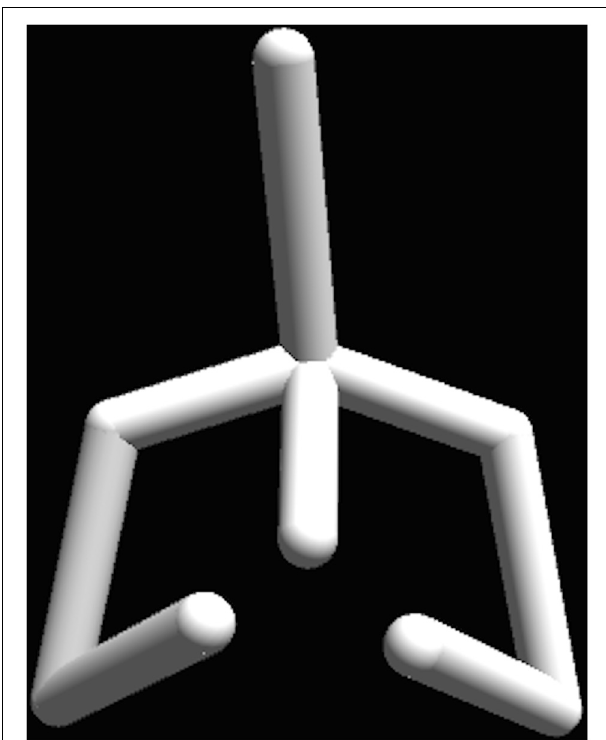
FIGURE 1 | The stick-figure stimuli display. The pelvis and legs were excluded from the stimulus display, which includes only the upper body. The biological motion was displayed at 60Hz (supported screen refresh rate) and came from real actors. The configuration of joins came from an underlying general skeleton model, keeping the body size, the proportions and other form cues the same for all stimuli.